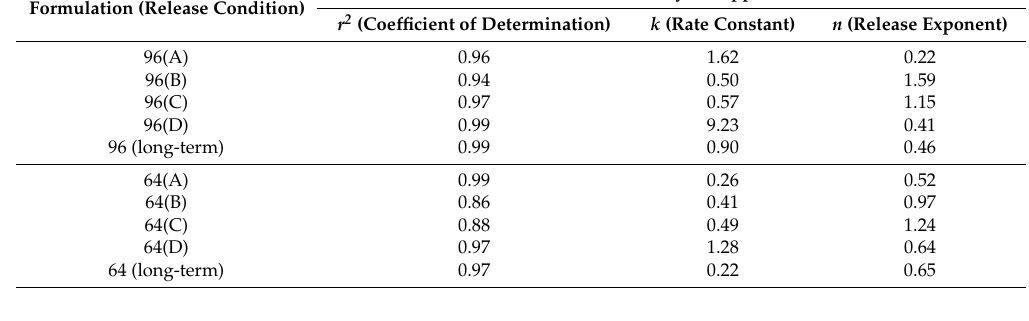
Table 3. Fitting parameters determined by the linear regression of log( M t / M ∞ ) against log t in Equation (1) for the LNG release from the depots made of formulations 96 and 64 under real time and four accelerated release conditions.